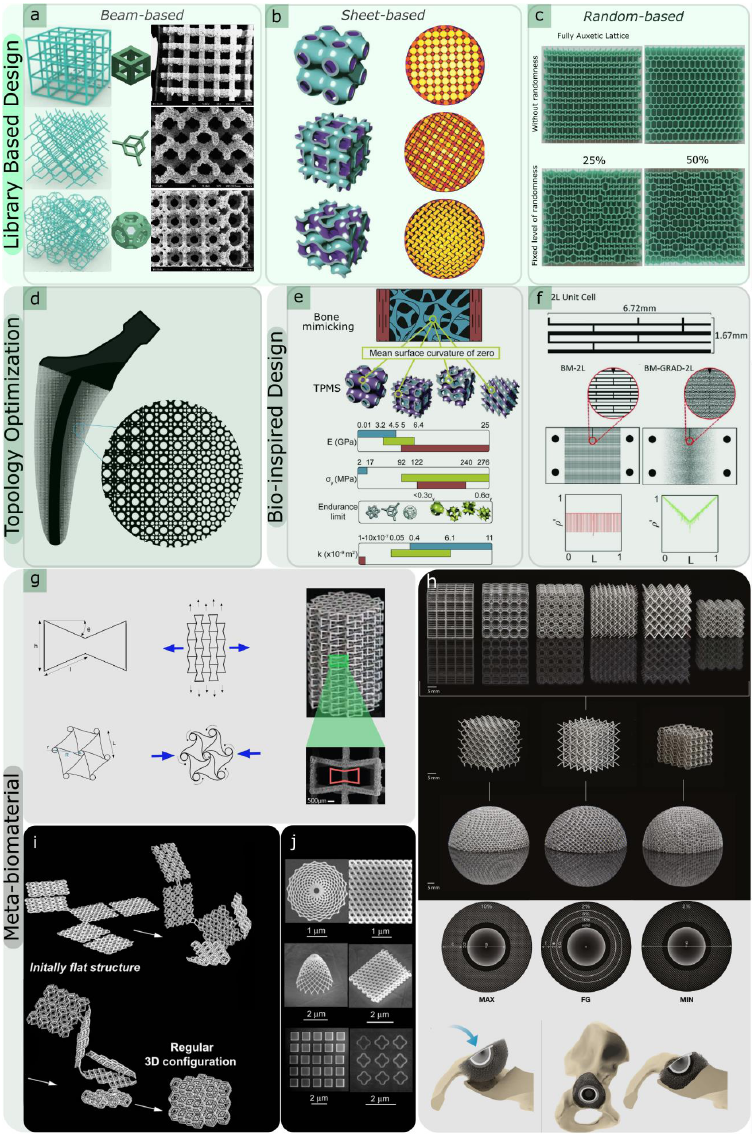
Figure 1. ( a – c ) Library-based designs: ( a ) beam-based unit cells, such as cubic, diamond, and truncated cuboctahedron (reprinted from Refs. [26,29] with permission, Copyright 2022 Elsevier), ( b ) surface-based unit cells, such as triply periodic minimal surfaces (TPMS) (reprinted from Ref. [30] with permission, Copyright 2022 Elsevier), and ( c ) disordered and random-based network structures (reprinted from [31] with permission, Copyright 2022AIP Publishing); ( d ) topology optimisation em- ployed in an orthopaedic implant (reprinted from Ref. [32] with permission, Copyright 2022 Elsevier); ( e , f ) bio-inspired designs, such as functionally graded hierarchical soft–hard composites inspired by ( e ) bone (reprinted from Ref. [30] with permission, Copyright 2022 Elsevier) and ( f ) nacre-like design exhibiting brick-and-mortar hierarchical unit cell structures (reprinted from Ref. [33] with permission, Copyright 2022 John Wiley and Sons); ( g – i ) meta-biomaterial designs: ( g ) auxetic properties, includ- ing re-entrant unit cells and chiral structures [34,35] (reproduced from [34] with permission from the Royal Society of Chemistry), ( h ) non-auxetic unit cells, such as cube, truncated cube, truncated cuboc- tahedron, diamond, body-centred cubic, and rhombic dodecahedron; three non-auxetic unit cells (diamond, body-centred cubic, and rhombic dodecahedron) were chosen for further evaluation in deformable meta-implants after they were evaluated for their quasi-static mechanical properties [36], ( i ) self-folding of origami lattices [37]; ( j ) 2D and free-form 3D nano-patterns on the surface of flat origami sheets using electron beam-induced deposition (EBID)